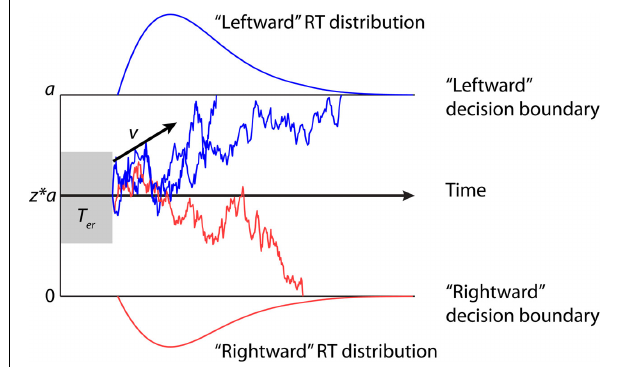
FIGURE 1 | Examples of trajectories of the drift-diffusion model. Two decision boundaries (0 and a ) represent the “leftward” and “rightward” decisions in the motion discrimination task. The drift rate v represents mean sensory evidence per unit of time. The magnitude of v is determined by the quality of the evidence. A positive v (as shown in the figure) indicates that the upper boundary is the correct choice. The diffusion process starts at a starting point between the two boundaries (denoted as a proportion of a by z ) until the accumulated evidence reaches one of two boundaries. If the correct boundary is hit (blue sample paths), the model makes a correct decision. Because of noise, the model may sometime hit the incorrect boundary (red sample path). The predicted response time (RT) is the sum of the duration of the diffusion process and the non-decision time T er